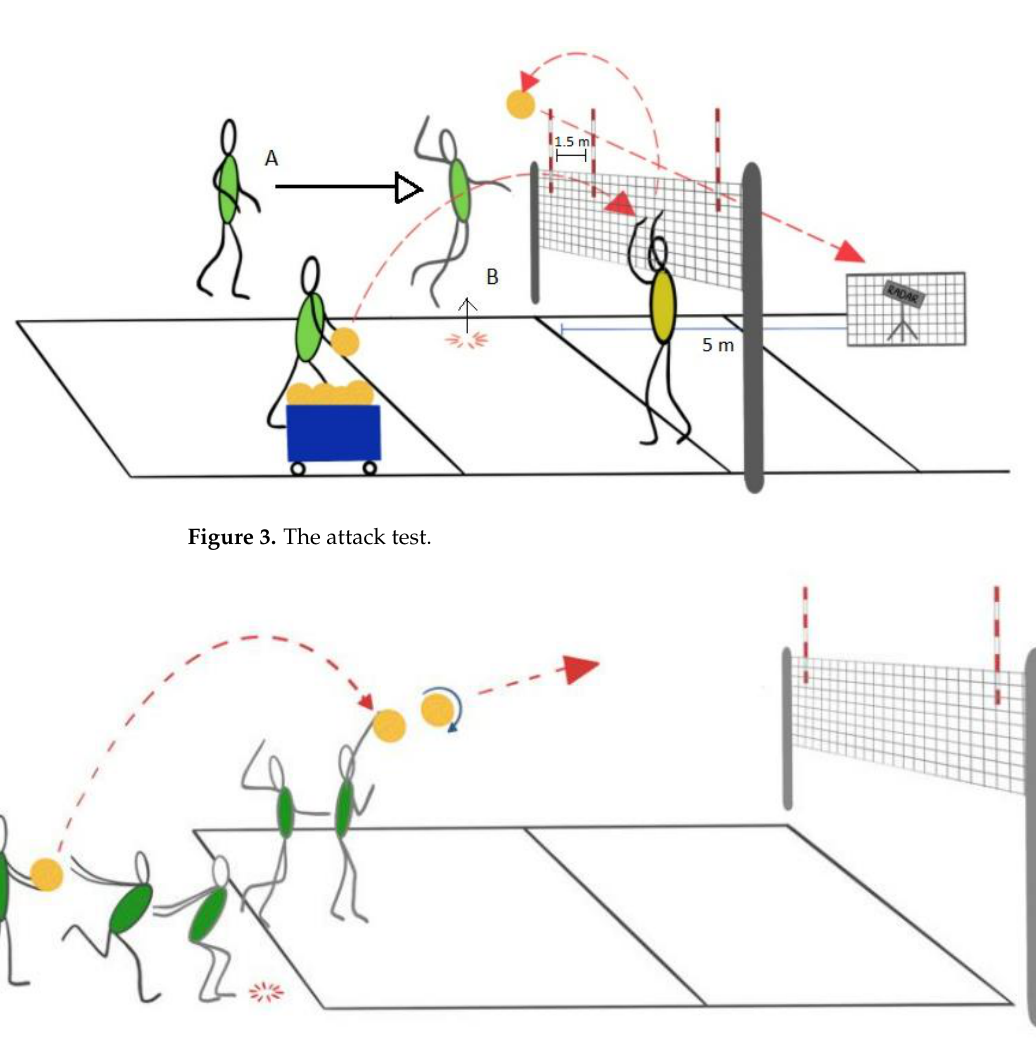
Figure 4. The volleyball service test.